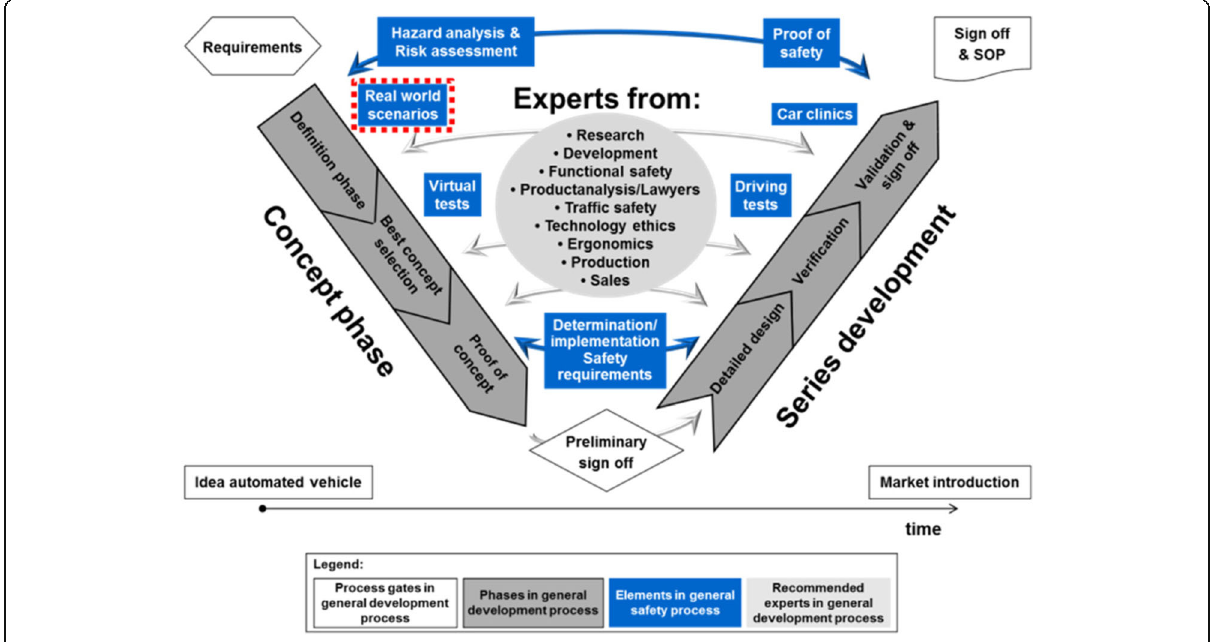
Fig. 14 Generic development-steps within a V-Model supported by real-world scenarios